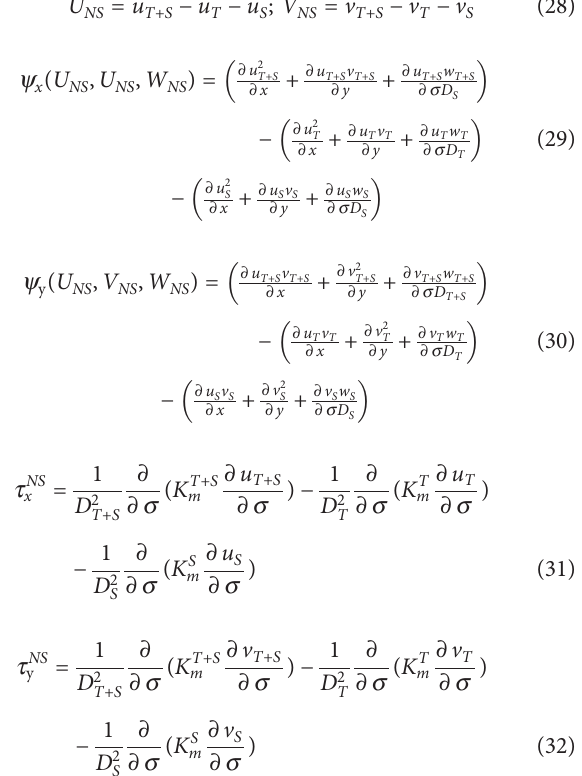
( Figure 10II ), the magnitudes and spatial distribution of the signi fi cant wave heights are similar in both Case 8 with large domain ( Figure 10IIA ) and Case 9 with small model domain ( Figure 10IIB ). The reconstructed wind fi eld in Case 0 ( Figure 10IIC ) slightly increases the signi fi cant wave height inside the